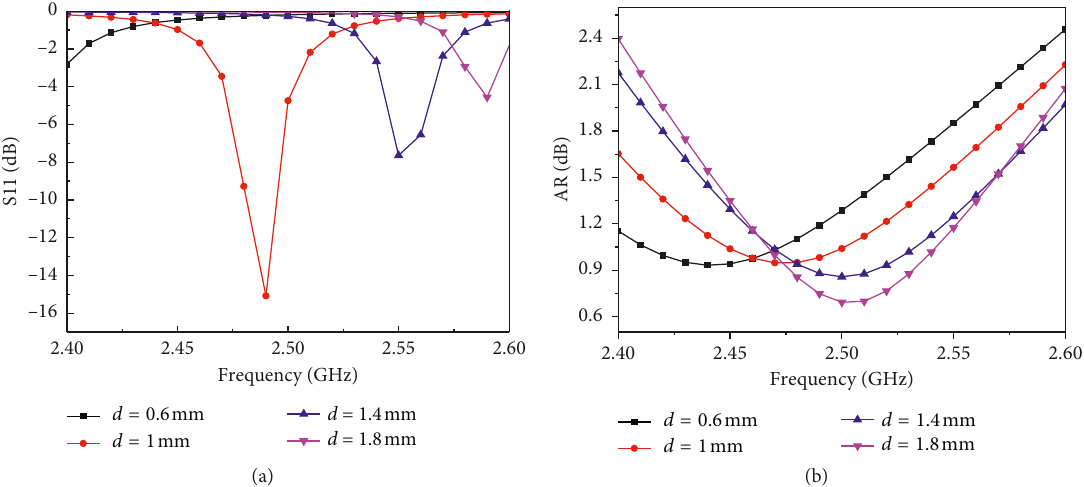
Figure 7: Effect of different d on antenna’s performance: (a) S11 and (b) AR.